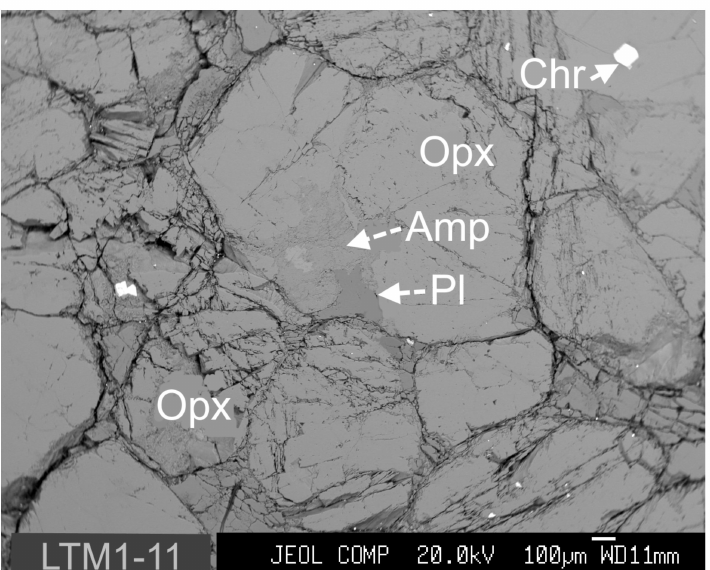
Figure 6. ( a – e ). Specimens of orthopyroxenite from the Lotmvara-I and Lyavaraka complexes (Figure 6a–c,e, respectively) and of fine-grained to microgranular harzburgite from the Chapesvara-I complex (Figure 6d).